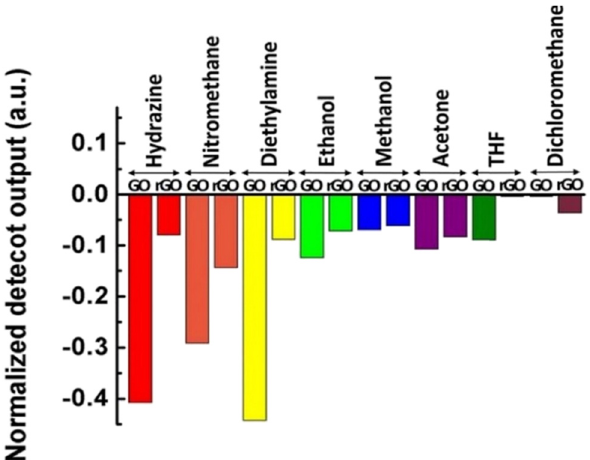
Figure 15: Comparative of sensing behaviour towards the di ff erent chemical gas by GO and rGO coated on POF. Reproduced from ref. [ 122 ]